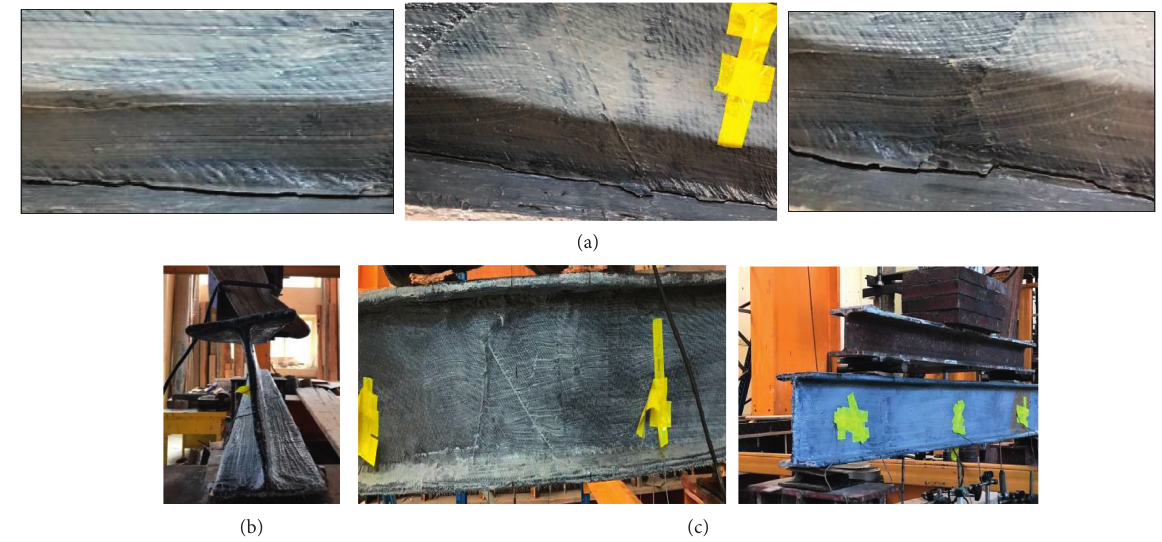
Figure 5: (a) Delamination cracks in group A beams. (b) Localized buckling of the web for S-B-1 and S-B-3 and (c) failure in group B beams. Local buckling on the compression flange for S-B-2 and S-B-4. Table 3: Failure moment and load results for tested beams. Case